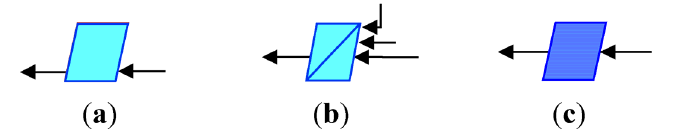
Figure 8. ( a ) Control bloc without controller; ( b ) Control bloc with controller; ( c ) Bloc